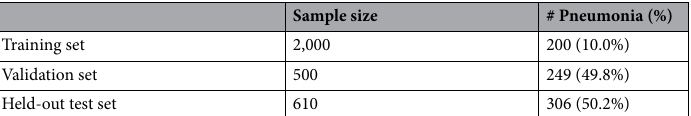
Table 1. Training, validation and held-out test sets used in our study. All three sets were sampled from the train or validation set of ChestX-ray14 dataset 9 . The training set was used to train data Shapley algorithm and compute Shapley values, the validation set was used to compute the predictor performance score during training, and the held-out test set was used to report the final results. Because the distribution of pneumonia labels in the ChestX-ray14 dataset is highly imbalanced, we sampled a larger proportion of pneumonia cases in the training set and sampled balanced validation and held-out test sets in this study.